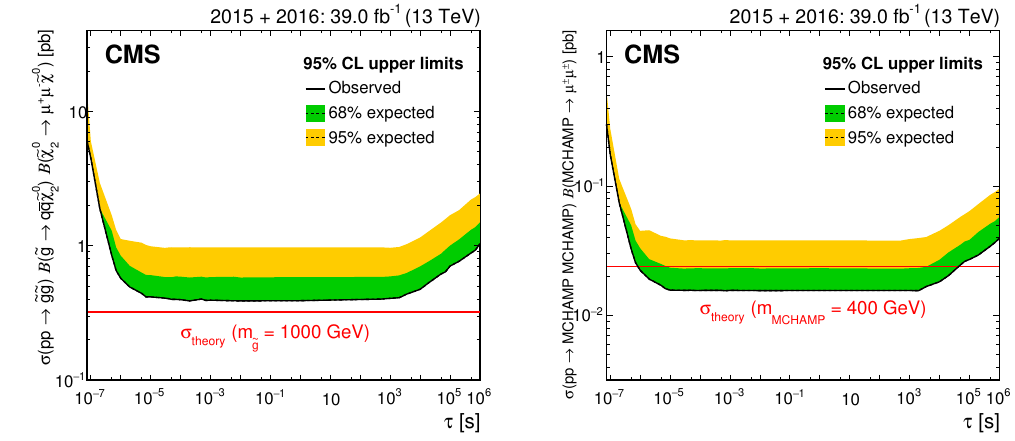
Figure 7 . The 95% CL upper limits on B (cid:27) for 1000 GeV gluino (left) and 400 GeV MCHAMP (right) pair production as a function of lifetime, for combined 2015 and 2016 data for the muon search. The theory lines assume B =